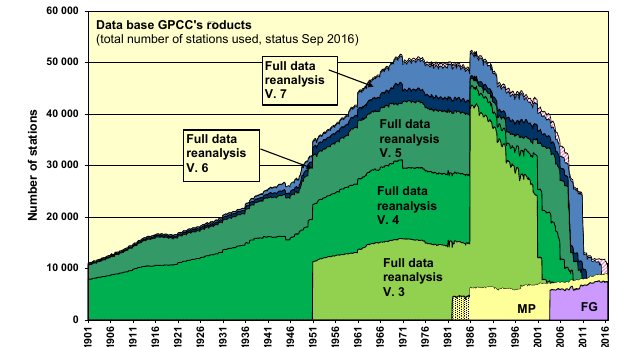
Figure 3. Update of the quantitative assessment of the global water cycle utilizing GPCCs land-surface precipitation analysis (Schnei- der et al., 2014).